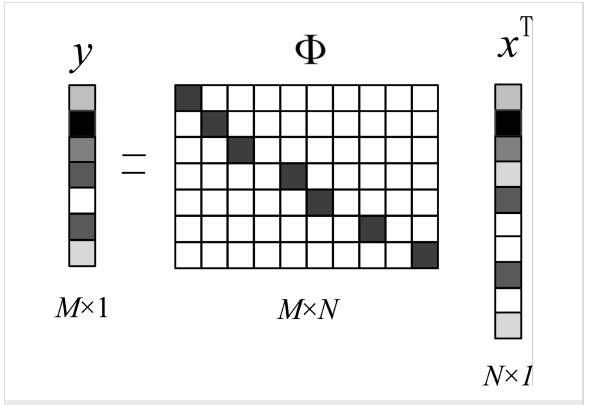
Figure 2: Mathematical model of compressed sensing AFM